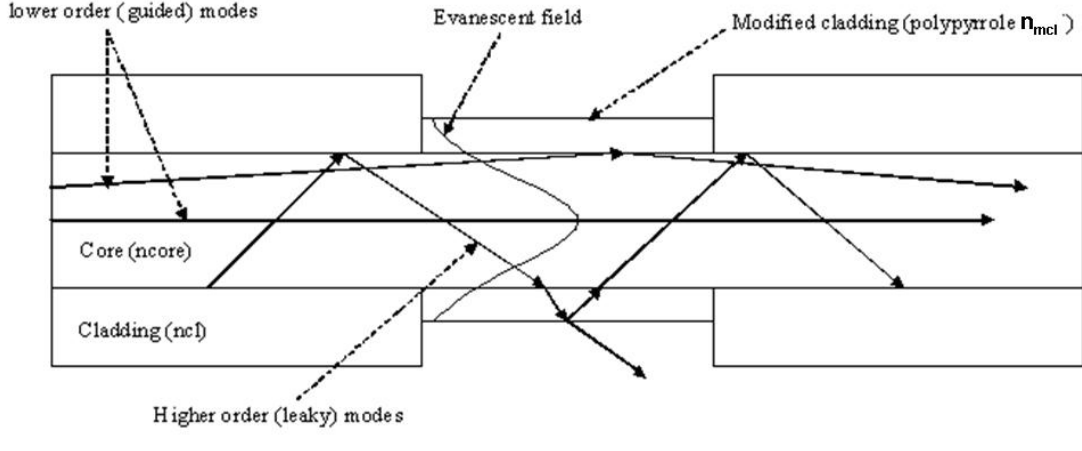
Figure 6. Schematic of the optical fiber sensor design showing the modified cladding